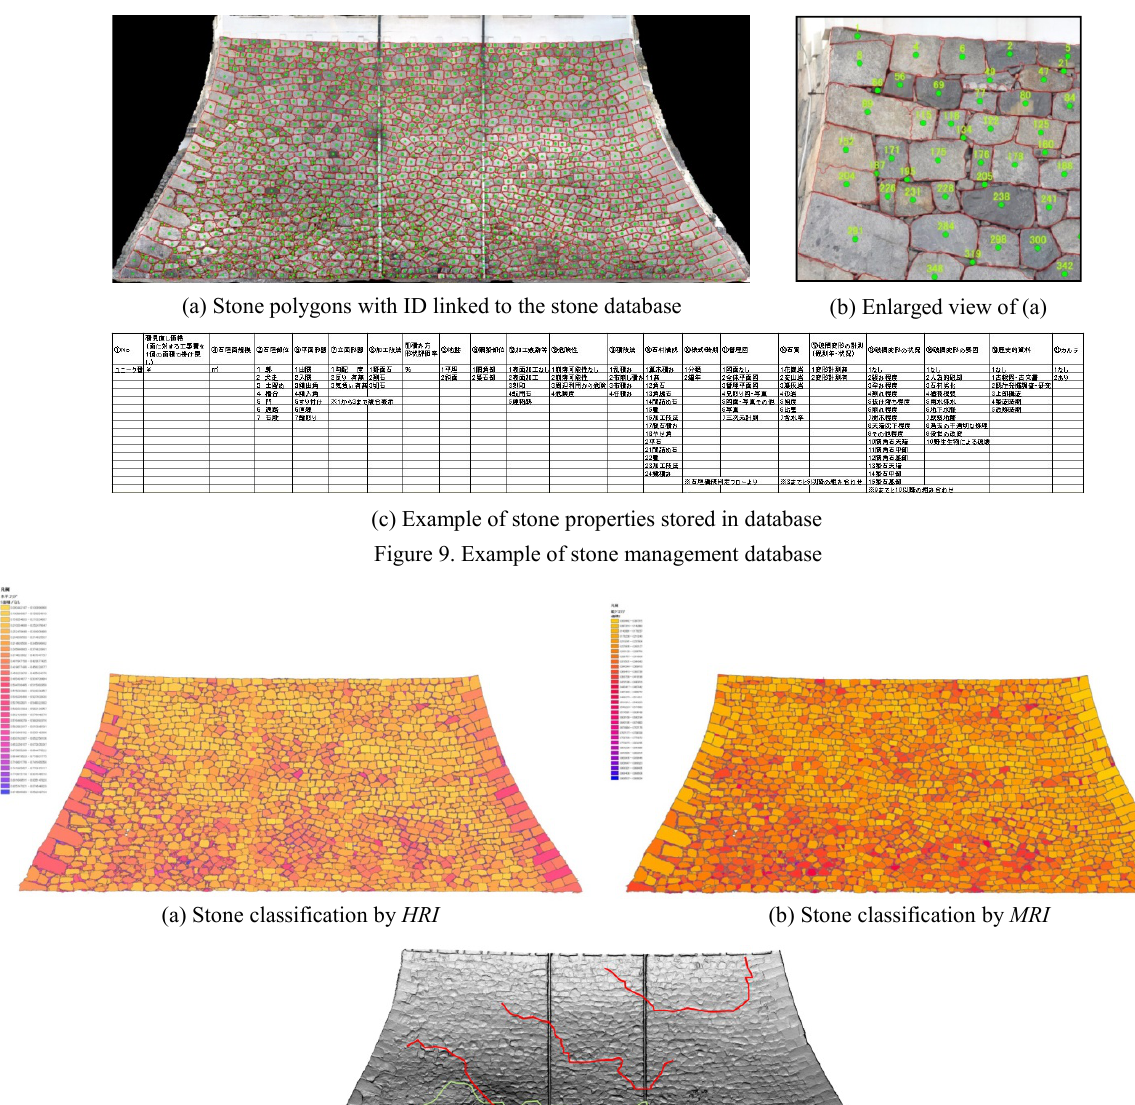
Figure 8. Extraction of individual stone polygons by the proposed method